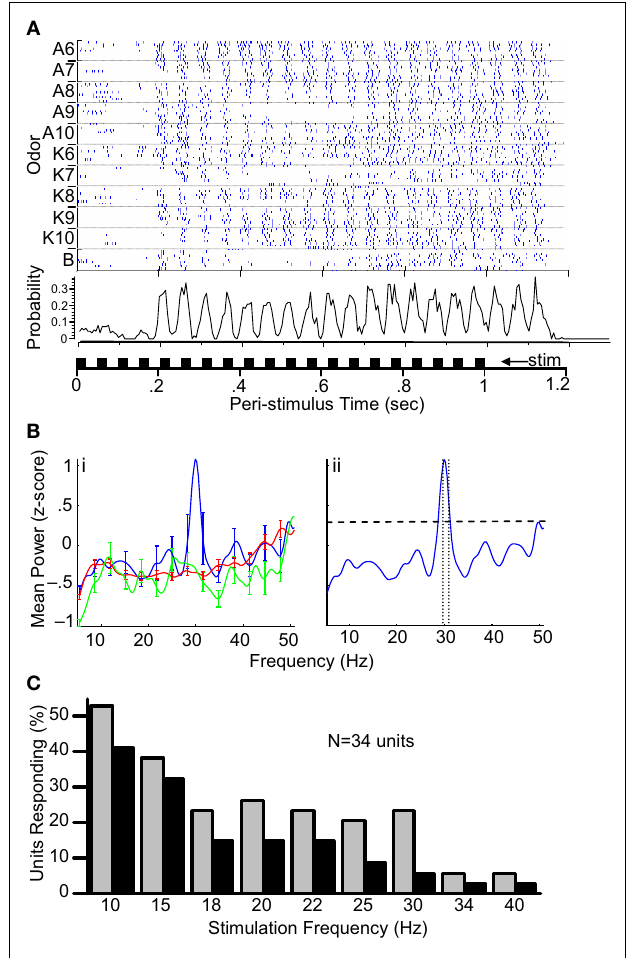
FIGURE 4 | Single units are entrained by pulsed odor stimulation. (A) Peri-event raster (top) and histogram (bottom) of a single unit in response to 1-s long 20-Hz pulse trains. Each hashmark represents a single action potential. Black horizontal lines demark 10 repetitions each for a given odorant or a blank (listed on the y-axis; A = alcohol, K = ketone, and the associated number represents the number of carbon units on the side chain). Peri- stimulus histogram (bottom) is binned at 0.005 s. Y -axis indicates spike probability and X -axis indicates time in seconds and pulse timing (inset below). Data past 1.2 s post-stimulus are not shown because this unit was completely quiescent for ∼ 0.5 s after the response ended. (B) Methods for identifi cation of pulse-tracking behavior of individual units. (i) Statistical method based on the comparison of mean PSDs in response to a pulsed (3 s at 30Hz; blue) or continuous (3 s; green) stimulus and for spontaneous activity (3 s; red). Error bars indicate SEM and are shown every 3 Hz. ( ii ). Highest peak criterion for identifi cation of pulse-tracking units based on relative height of PSD peak around stimulus pulse frequency. Dotted lines + / − 0.5 Hz around 30 Hz input frequency mark the frequency criterion for the peak. Dashed line marks the highest PSD value that is not at the pulsing frequency. Y -axis shown on left is the same for i and ii . (C) The percentage of responding units (34 total, 4 animals) by frequency. Grey bars indicate count using highest peak criteria (cf. 4Bii ) and black bars indicate count using statistical criteria (cf. 4Bi